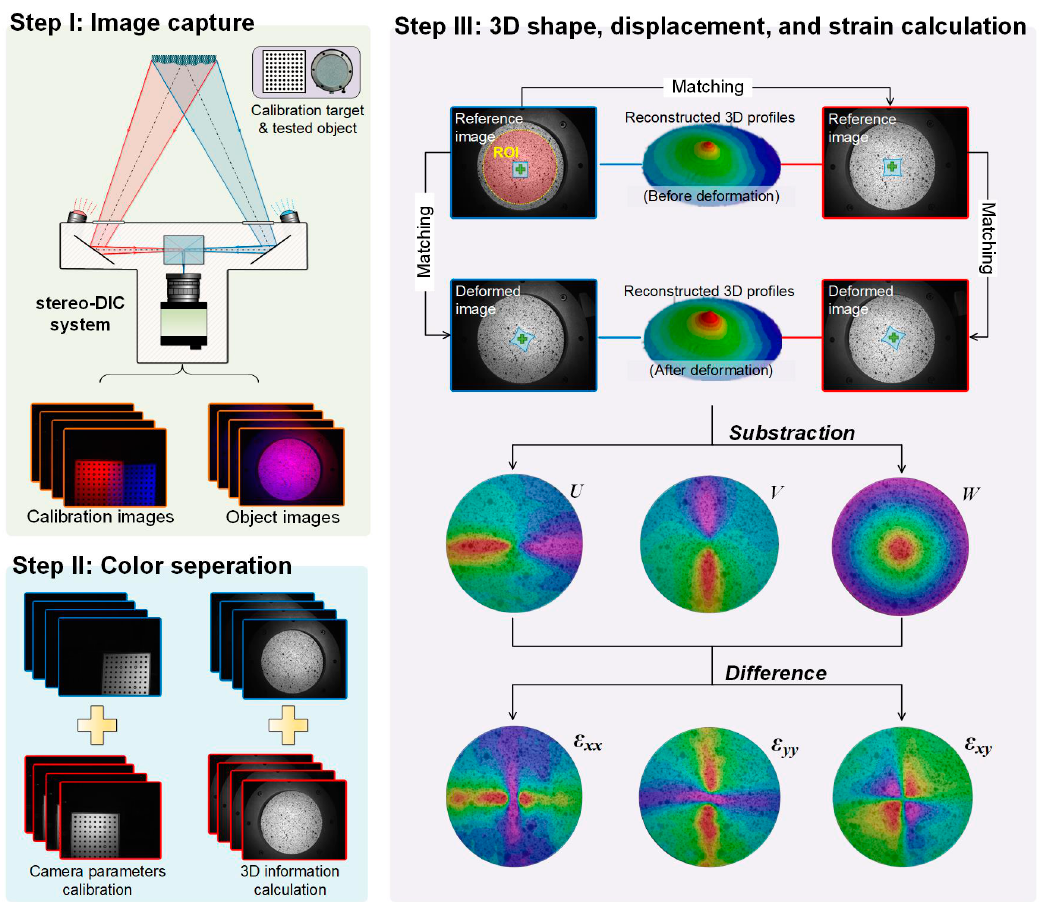
Figure 3. Schematic of the implementation procedure.